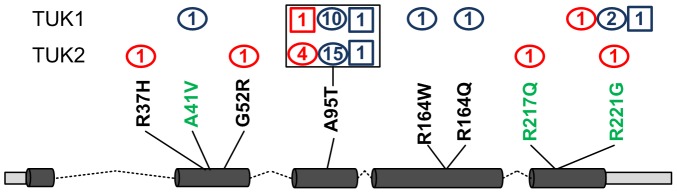
SNVs identified in gene GZMM.Schematic showing number of subjects in TUK1 (top row) and TUK2 (bottom row) having nonsynonymous SNVs within the GZMM gene, with novel variants in black and those described in dbSNP in green. Subject counts in blue are for pain insensitive subjects and in red, pain sensitive. Squares represent homozygous and ovals heterozygous mutations. Exons are shown as dark cylinders, UTRs pale grey rectangles and introns dotted line.